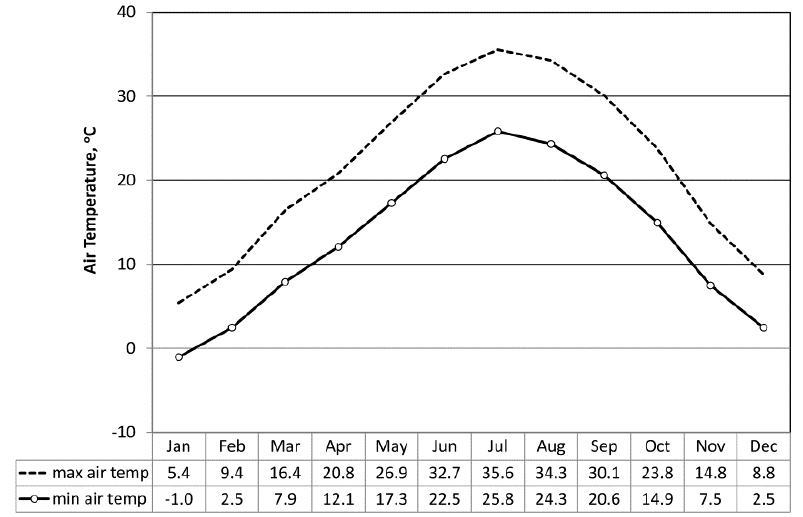
Figure 1. Five year average of mean monthly maximum and minimum temperatures for Tehran (Geophysics station, 2005–2009).